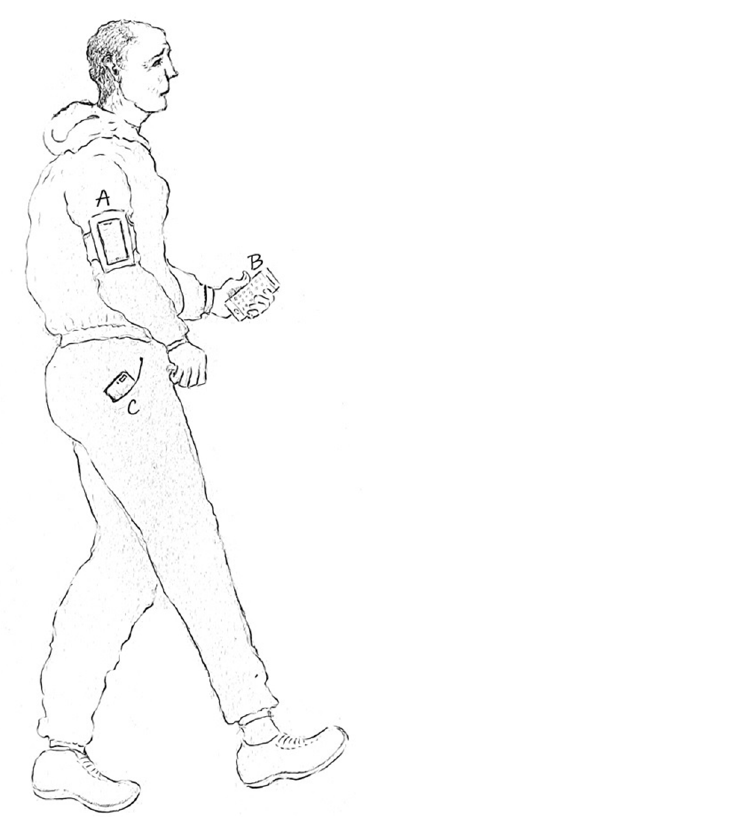
Figure 1. The smartphones’ positions during the six-minute walk test. ( A )—Arm position, ( B )—Hand position. ( C )—Pocket position.